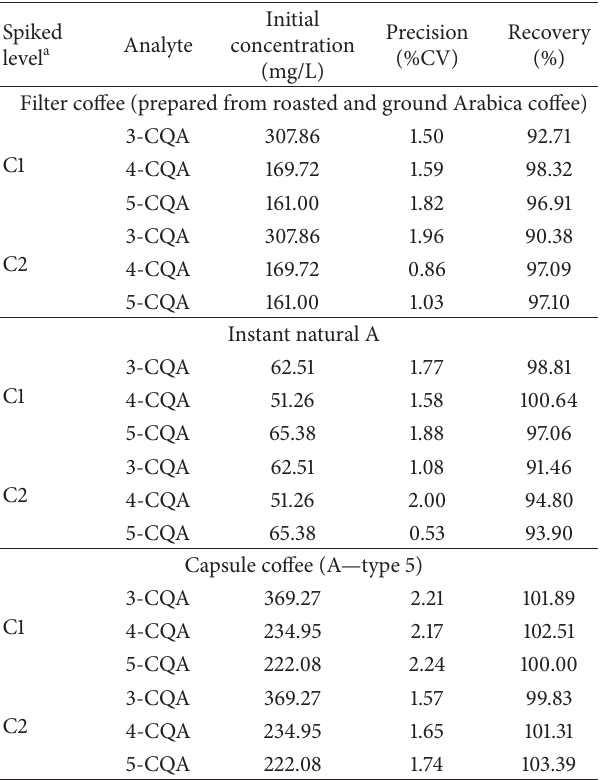
Table 2: Validation parameters for CQAs analysis by HPLC-DAD. Validation